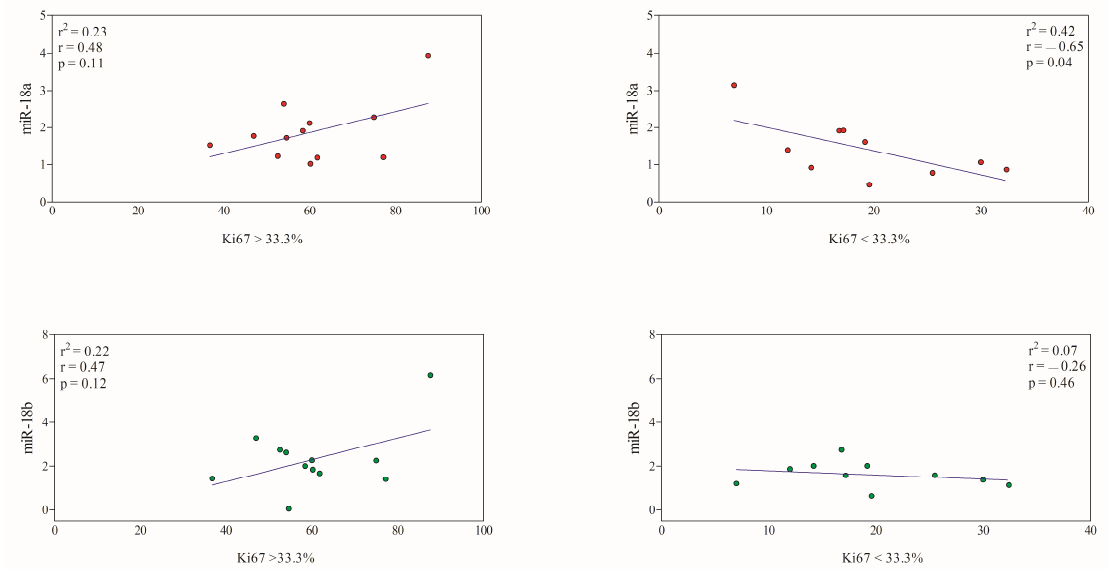
Figure 4. Correlation between miRNA expression and Ki67 index. A significant negative correlation was observed only between miR-18a (red circles) expression levels and Ki67 index < 33.3% ( p < 0.05). The miR-18b (green circles) gene expression did not show a significant correlation with Ki67 index. The colored circles (red; green) refer to miRNA expression levels in CMTs. Considering benign vs. malignant CMTs, the Ki67 positivity was 21.97 ± 10.21% and 47.34 ± 22.79%, respectively. In this case, a significant positive correlation was found